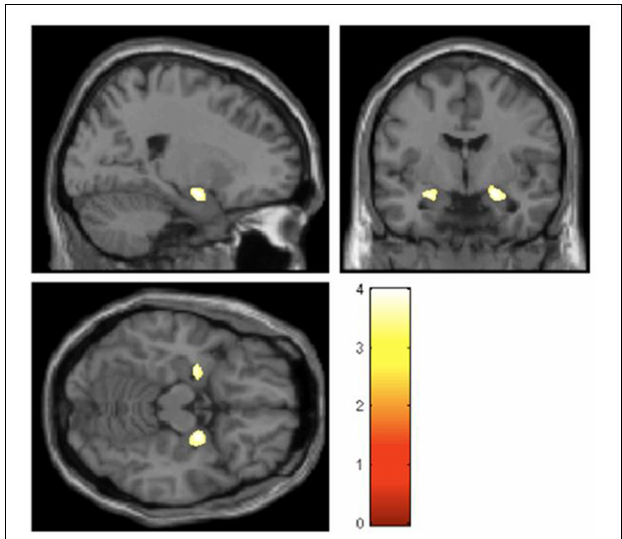
FIGURE 2 | Regions of gray-matter volume difference in hypermobile participants compared with the non-hypermobile group (threshold P < 0 . 001 uncorrected) (Eccles et al.,